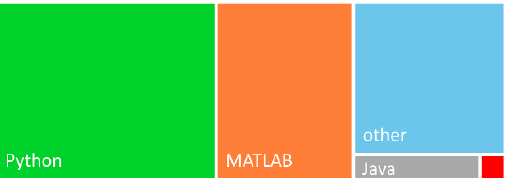
Figure 6. Programming languages utilized to write the MOO algorithms in the reviewed journal articles. A larger area corresponds to a higher number of algorithms based on that programming language. The “other” category also includes those journal articles which did not declare the programming language.